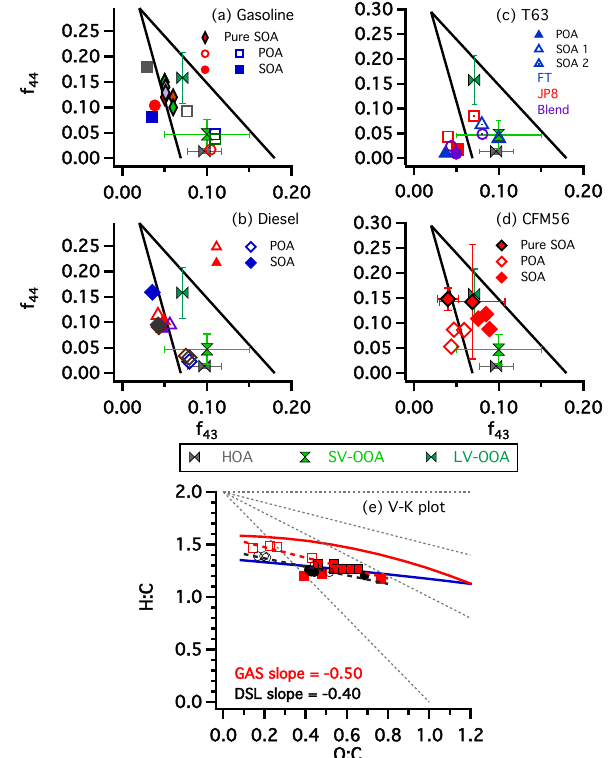
Figure 9. (a)–(d) show triangle plots for gasoline vehicle, diesel ve- hicle, and gas-turbine engine experiments. Average ambient HOA, SV-OOA, and LV-OOA are also shown, and the error bars indicate the range in f 44 and f 43 reported by Ng et al. (2011b). (e) shows a van Krevelen plot of the gasoline and diesel data from (a) and (b) , with POA shown as open symbols and SOA as closed symbols. F 44 and f 43 are converted to O:C (Aiken et al., 2008) and H:C (Ng et al., 2011a) using published